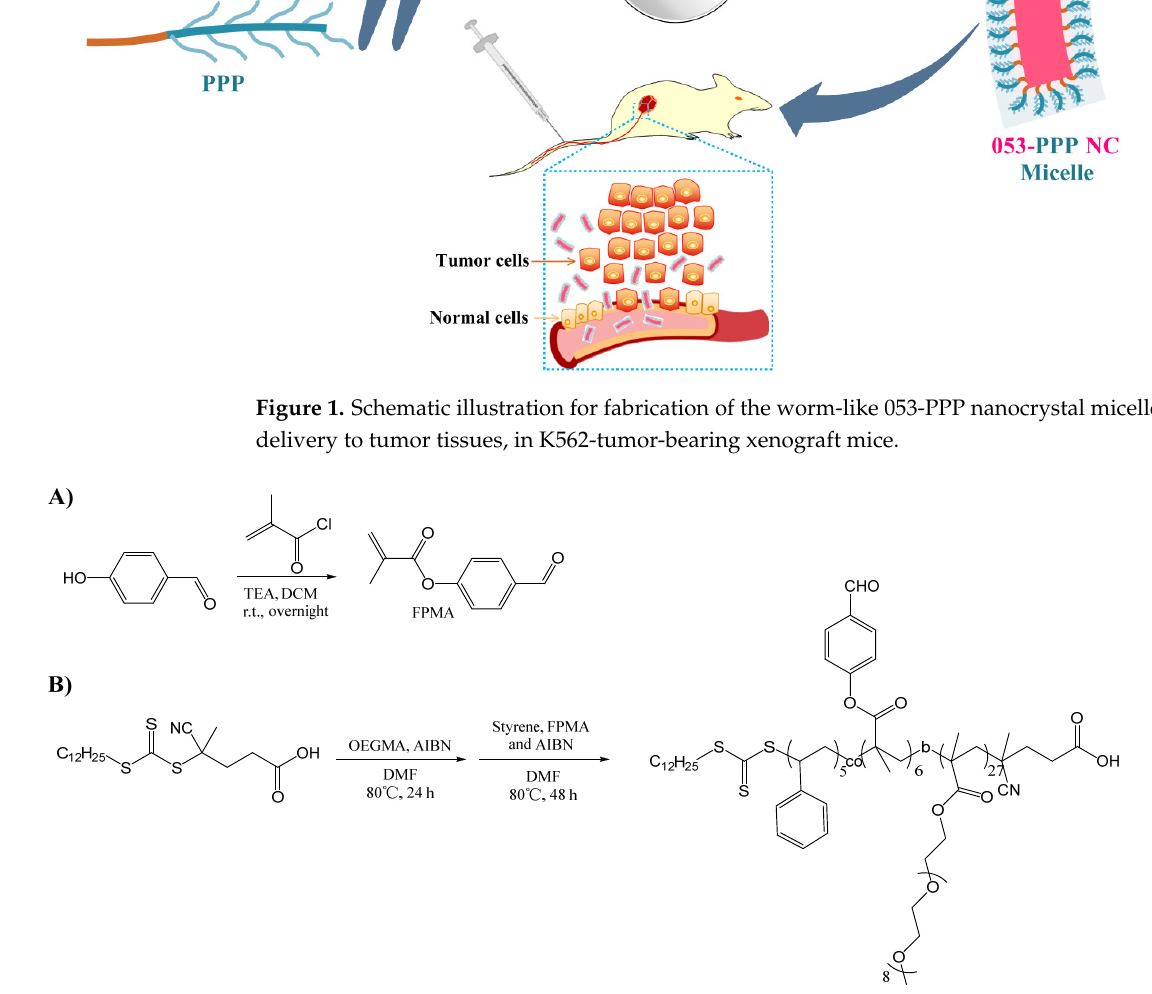
Figure 2. Schematic illustration of the synthesis of ( A ) the monomer 4-formylphenyl methacrylate (FPMA) and ( B ) the amphiphilic polymer POEGMA-b-P(St-co-FPMA) used as the stabilizers for the 053-nanocrystal